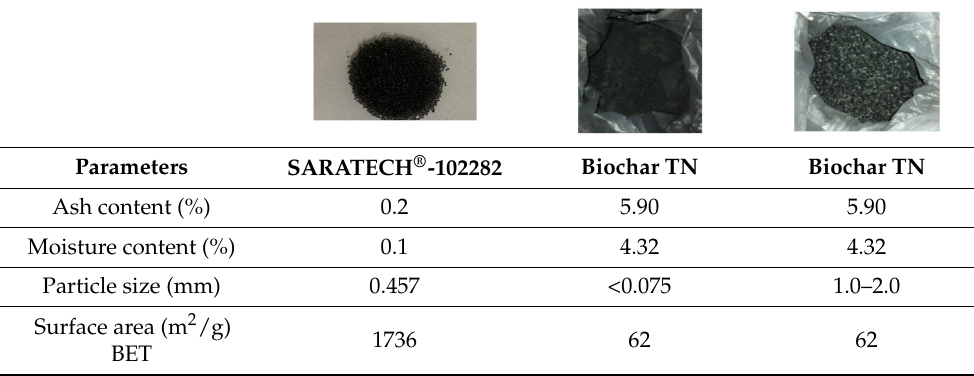
Table 3. Characteristics of the